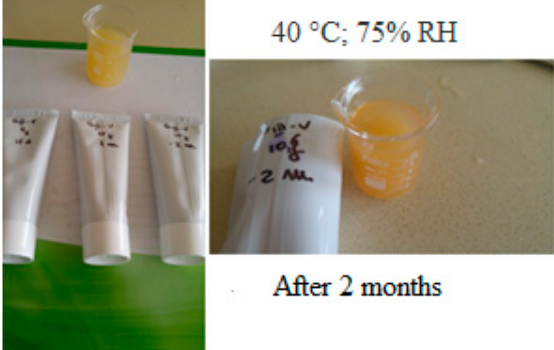
Figure 7. Image of formulation before ( left ) and after stability test ( right ). Table 4. Parameters determined after conditioning of the gel formulation.